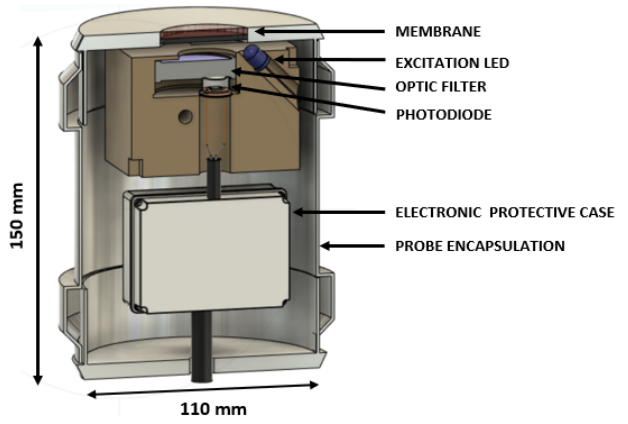
Figure 2. Schematic representation of the main components and encapsulation of the oxygen sensor.